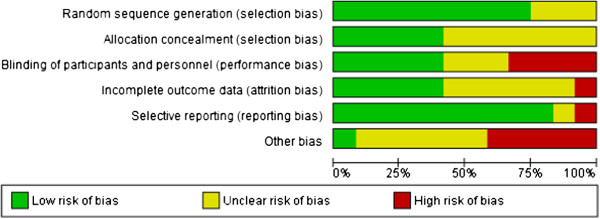
Methodological quality graph: judgments about each methodological quality item presented as percentages for all included studies (n = 12).